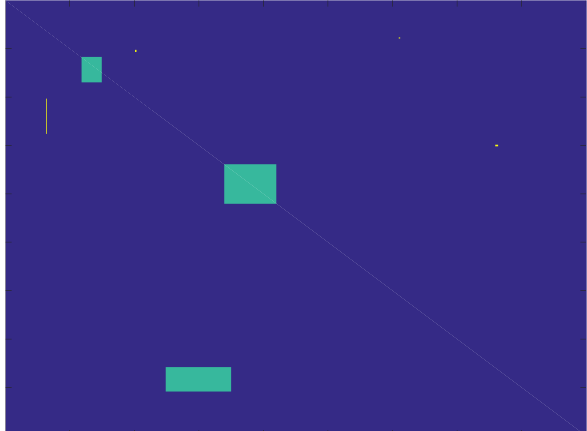
Figure 3. The simulation without noise, turquoise is water, blue is oil slick, and yellow is oil look-alike.